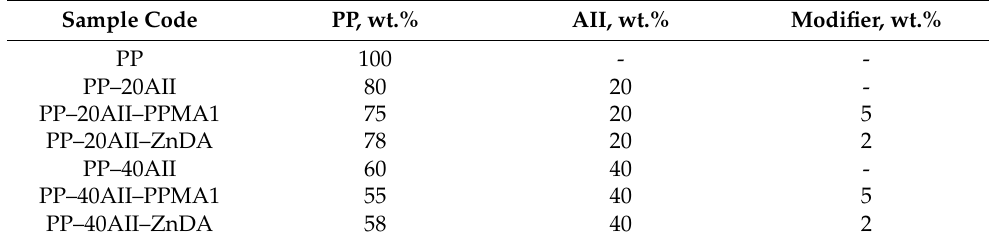
Table 1. Codes and the compositions of PP samples produced with internal mixers.